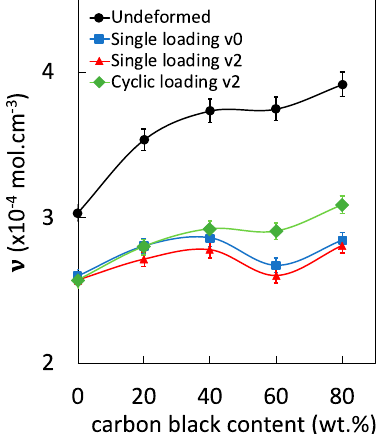
Figure 1. Network chain densities of EPDM with filler content of 0, 20, 40, 60, and 80 phr for untested (undeformed) specimens (ring symbols), for cyclically loaded specimens at the nominal strain rate 1 s ⁻ 1 (diamond symbols), for single loaded specimens at the nominal strain rate 10 ⁻ 2 s ⁻ 1 (square symbols), and for single loaded specimens at the nominal strain rate 1 s ⁻ 1 (square symbols).